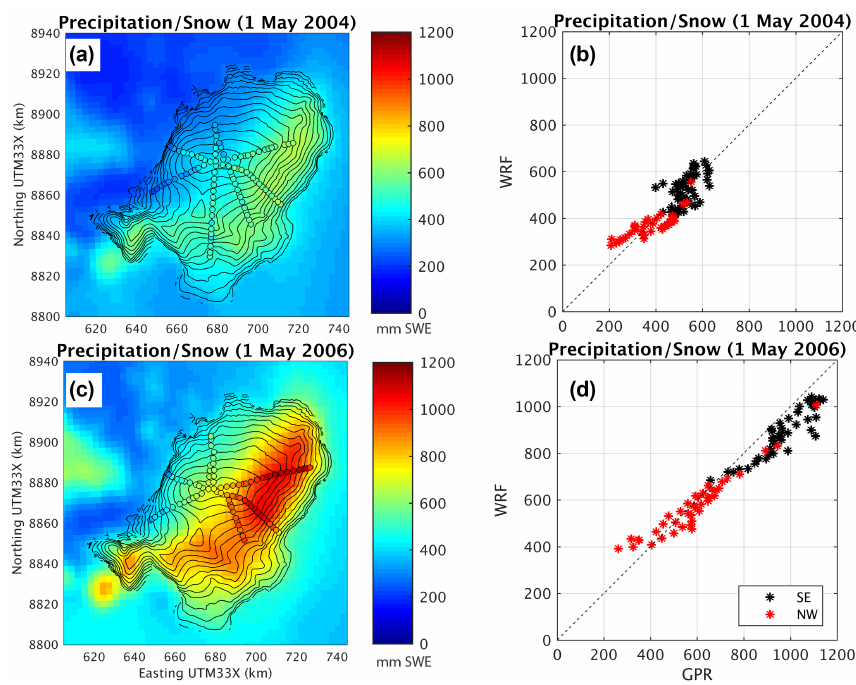
Figure 5. (a) Simulated and GPR-derived winter accumulation at Austfonna 1 May 2004. (b) Scatterplot of data from GPR locations in (a) . Red dots show points located northwest of summit, and black dots show points located southeast of summit. (c) Same as (a) for 1 May 2006. (d) Same as (b) for 1 May 2006.